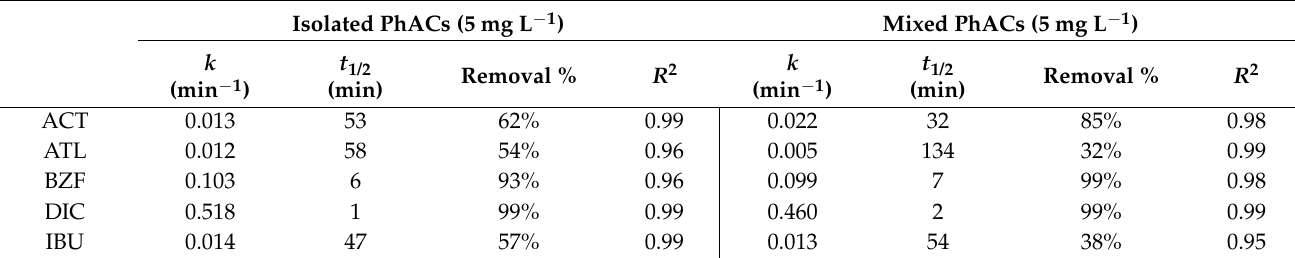
Table 5. Results of photolysis experiments: k , pseudo-first-order rate constant (min − 1 ); t 1/2 , half-life time (min); removal %, percent removal after 60 min of irradiation; and R 2